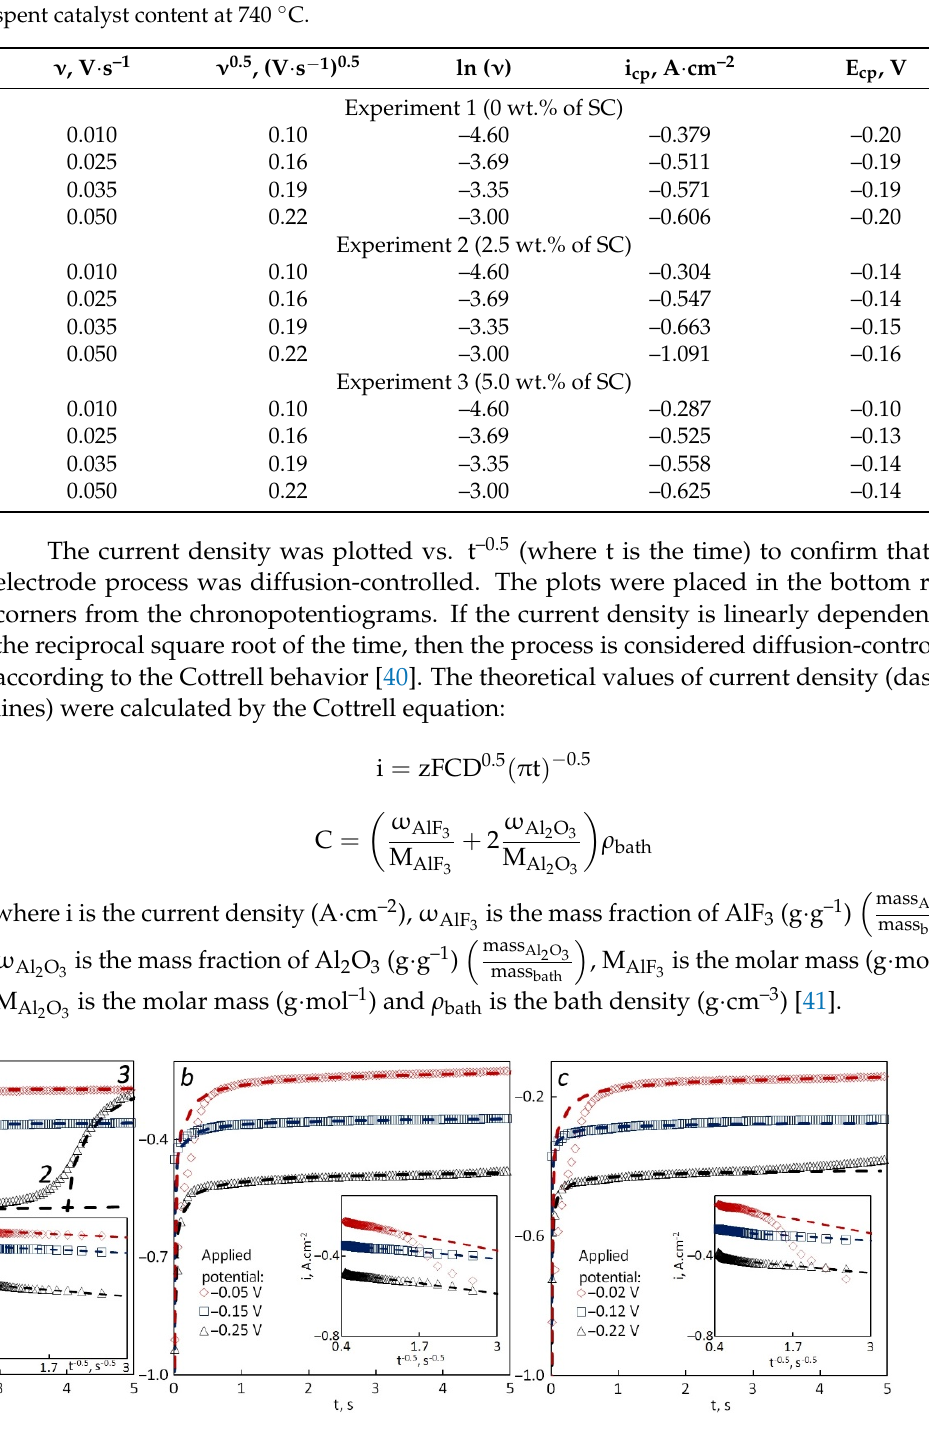
Figure 2. Chronoamperograms recorded for tungsten in 85LiF–15AlF 3 at 740 °C at different applied potential and the dependencies of current density vs. time to the power − 0.5 (bottom right) for different spent catalyst content: ( a ) 0 wt.%, ( b ) 2.5 wt.%, ( c ) 5 wt.%.